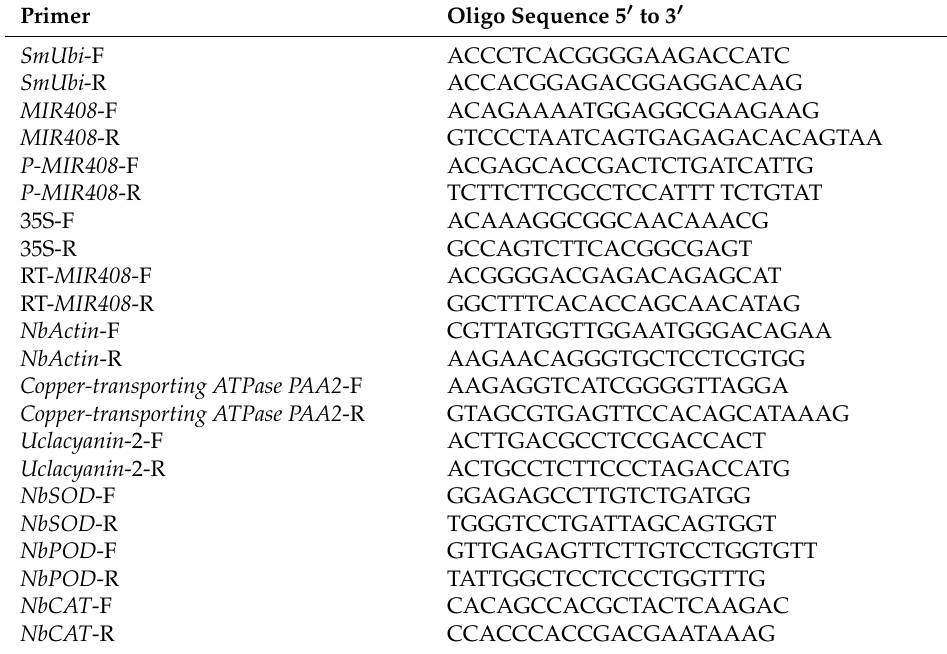
Table 1. List of primers used for